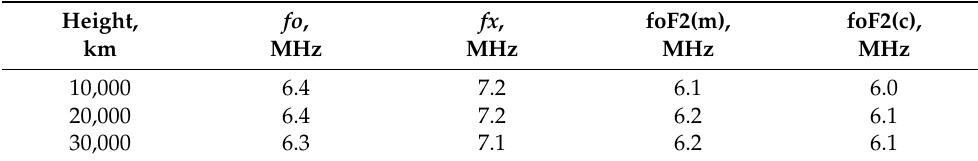
Table 2. Inaccuracy in the estimation of foF2 , 00:00 LT.